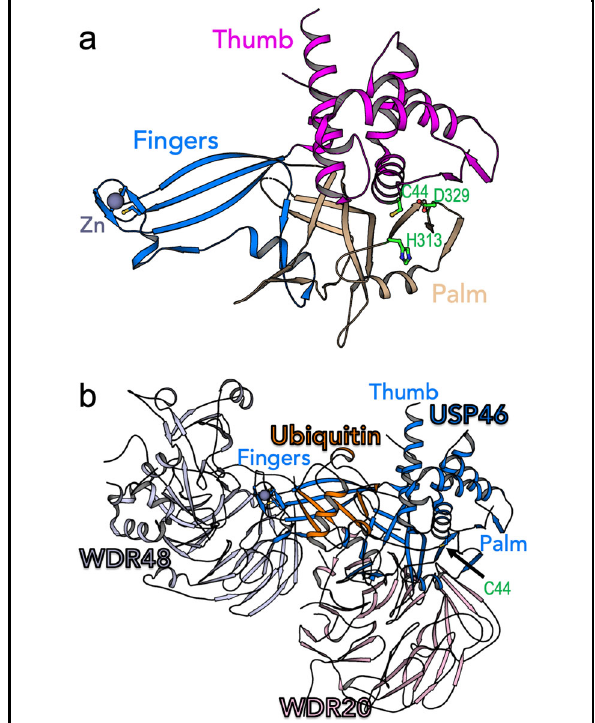
Fig. 3 Structure of USP46 and its regulatory partners. a The structure of USP46 subdomains. Residues of the catalytic triad located at the interface between the palm and the thumb subdomains are shown as green sticks (PDB code 5L8H 40 ). b A model of USP46 complex based on superposition of the structures of USP46 with covalent ubiquitin (Ub-VME) (PDB code 5L8H 40 ) with the non-covalent complex of USP46:WDR20:WDR48 (PDB code 6JLQ 39